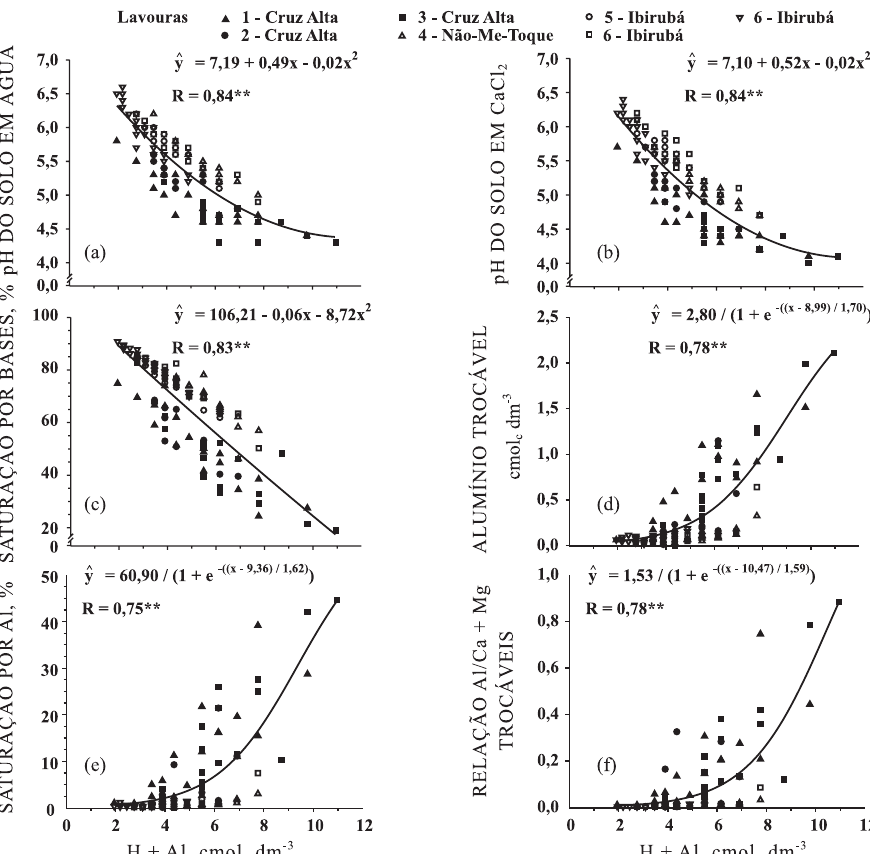
Figura 2. Relação entre a acidez potencial e os indicadores de acidez do solo: (a) pH em água; (b) pH em CaCl ; (c) saturação por bases; (d) alumínio trocável; (e) saturação por alumínio; (f) relação Al/Ca + Mg 2